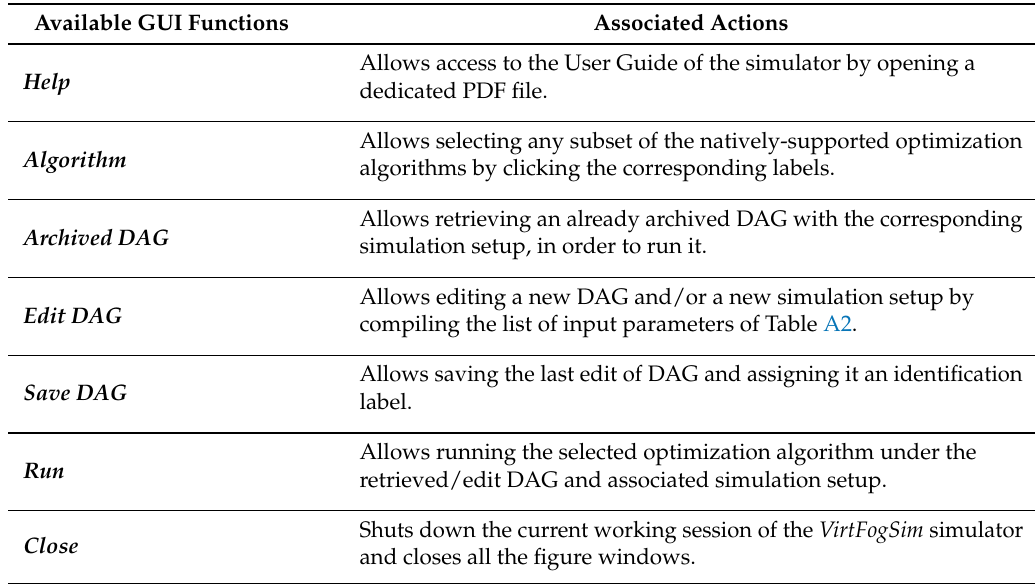
Table A1. A synoptic overview of the functionalities offered to the user by the GUI